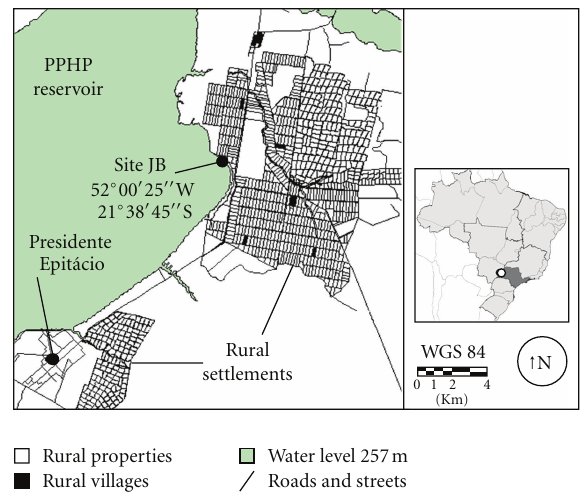
Figure 1: Site JB localization according to PPHP reservoir at water level of 257 meters upper sea level and distinct types of human distribution (rural properties, rural villages, and urban area). Cartographic data: